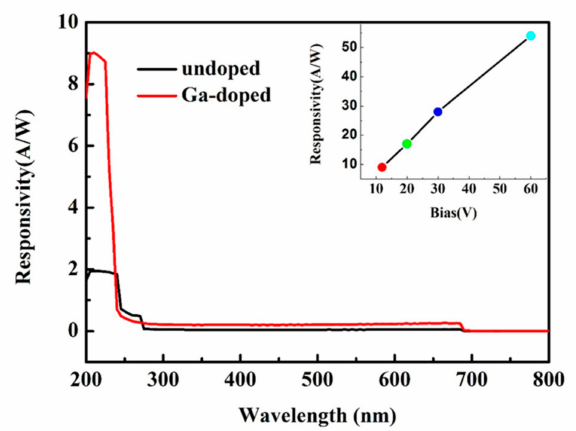
Figure 7. Spectral response of the ZnMgO sample with and without Ga